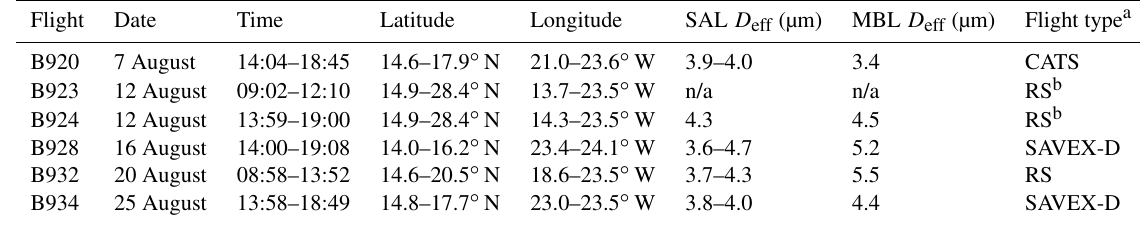
Table 1. The AER-D research